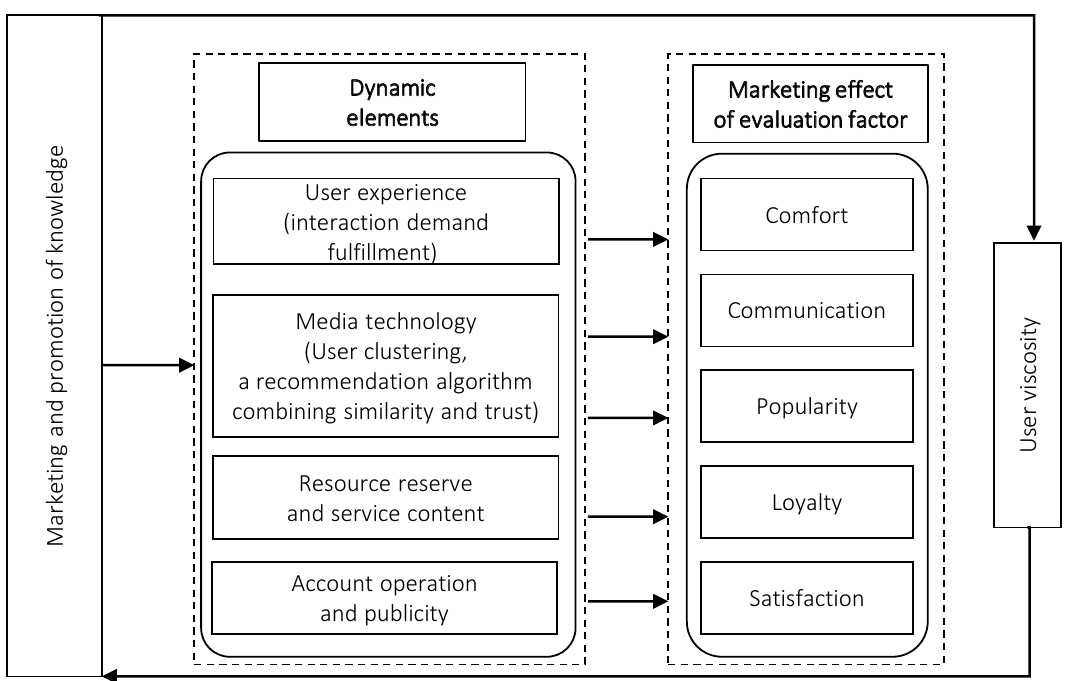
Figure 3. Dynamic model of marketing promotion of knowledge services in university